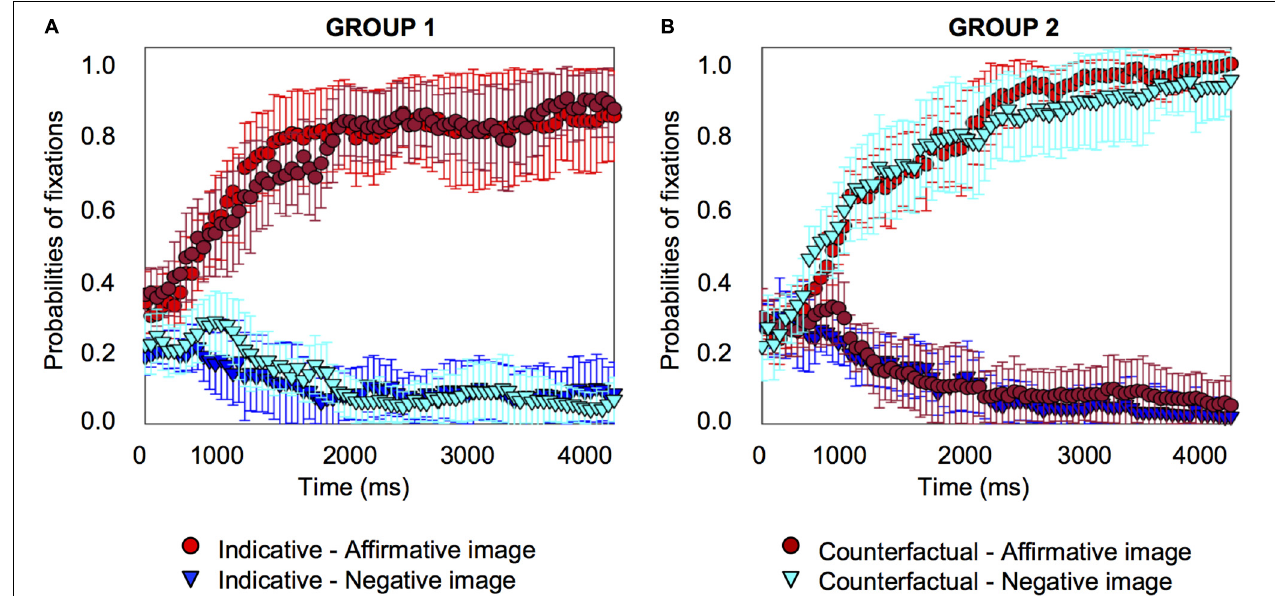
FIGURE 8 | Individual differences probabilities of fixations for indicative and counterfactual sentences for the subset group of nine participants who looked at the affirmative printed words for counterfactuals (A) , and the second subset group of 13 participants who looked at the negative printed words only or at the affirmative and negative printed words for counterfactuals (B) in Experiment 3. Error bars are 95% confidence intervals within